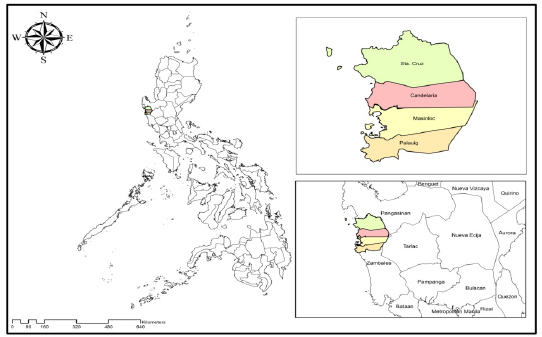
Figure 1. Geographic location of the study areas